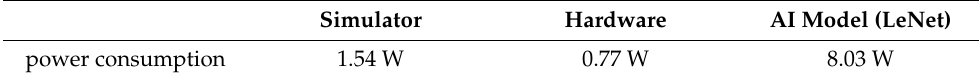
Table 7. Power consumption of Asimov simulator, hardware and AI